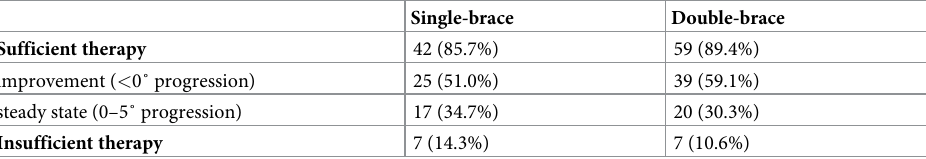
Table 2. Patient outcome 2 years after brace deposition (sufficient therapy � 5˚curve